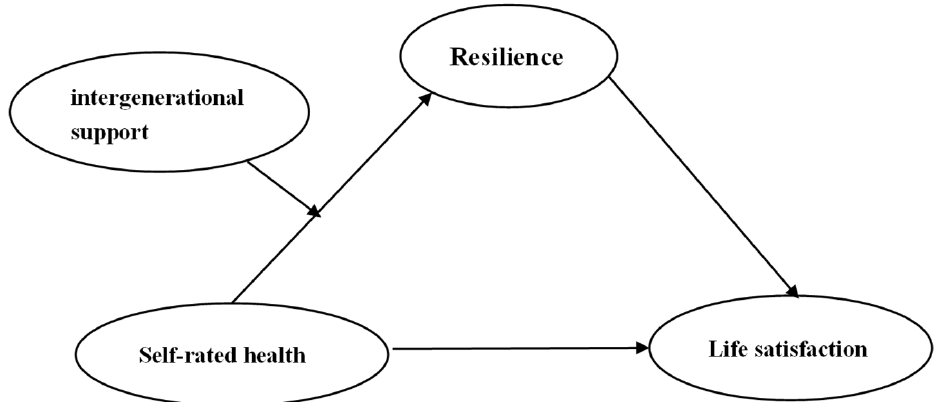
Figure 1. Moderated mediation model predicting life satisfaction. Hypothesis 1. Self-rated health is positively correlated with life satisfaction